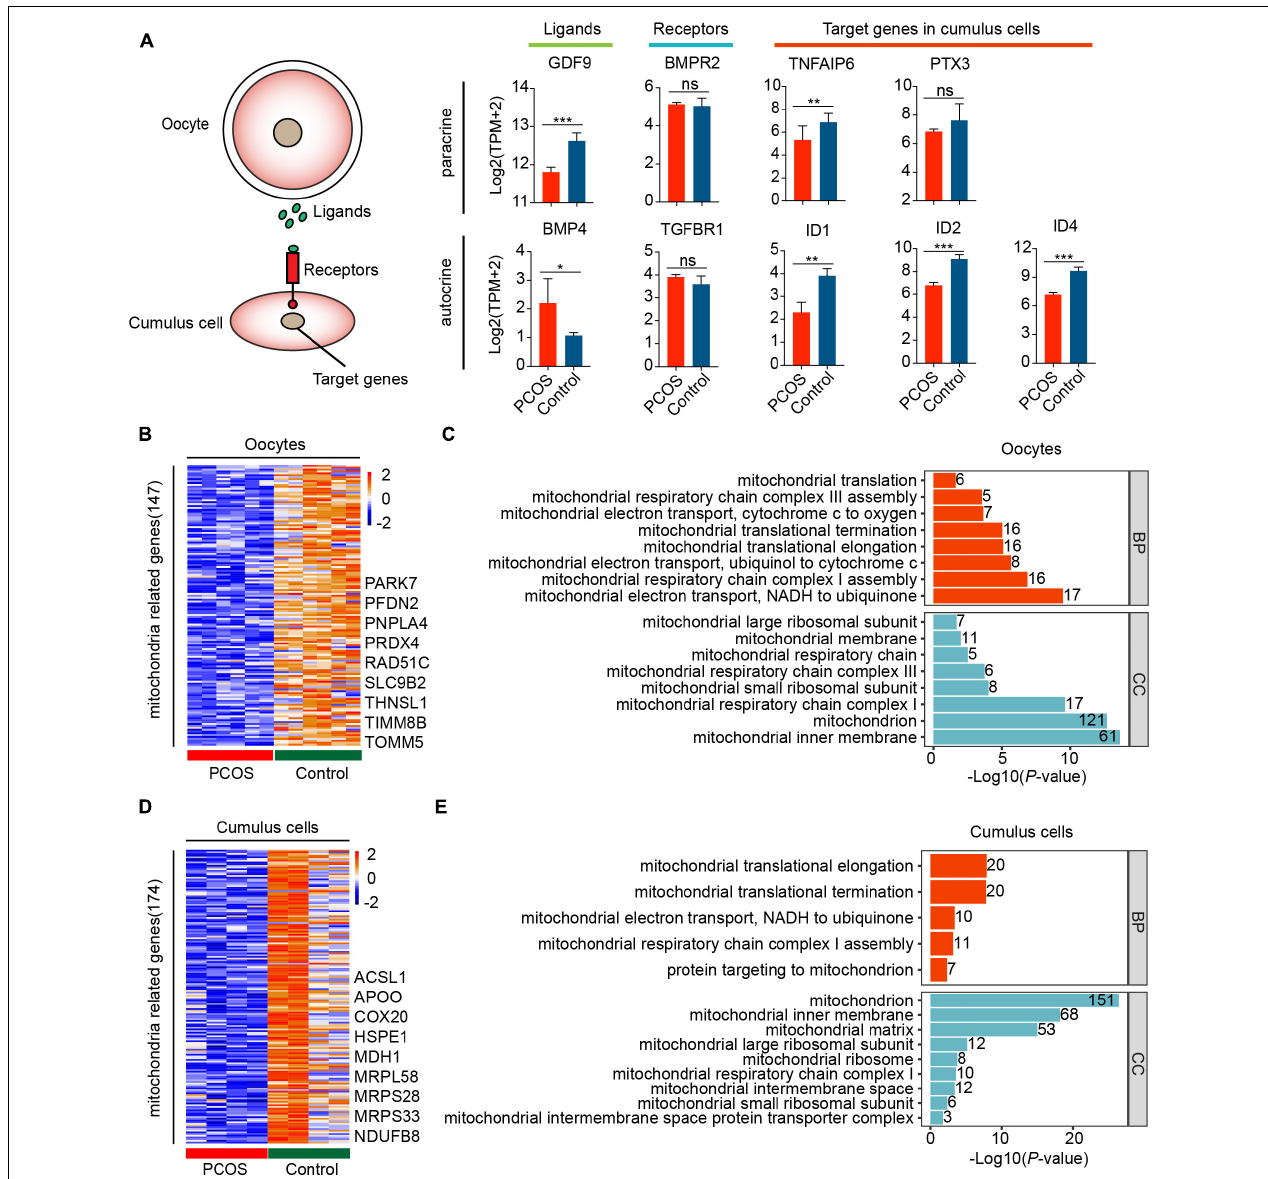
FIGURE 3 | Disorder of mitochondrial function and communication in CCs and oocytes with PCOS. (A) The TGF- β signaling pathway is involved in the oocyte–GC interactions. The schematic diagram at the left shows the relationship among these genes. The diagrams at the right show the relative expression levels [log2 ([TPM+2)] of ligands, receptors, and target genes between PCOS and control in oocytes ( n = 3 participants) and CCs ( n = 2 participants). Data represents mean ± SD. * p < 0.05, ** p < 0.01, *** p < 0.001, ns, not significant. (B) Heat map of DEGs involved in the mitochondria that were downregulated in oocytes with PCOS. (C) Gene ontology (GO) enrichment analysis of downregulated mitochondria genes in PCOS oocytes. The red bars represent biological process (BP), and the blue bars represent cellular component (CC). (D) Heat map of DEGs involved in mitochondria downregulated in PCOS CCs. (E) GO enrichment analysis of downregulated mitochondria genes in PCOS